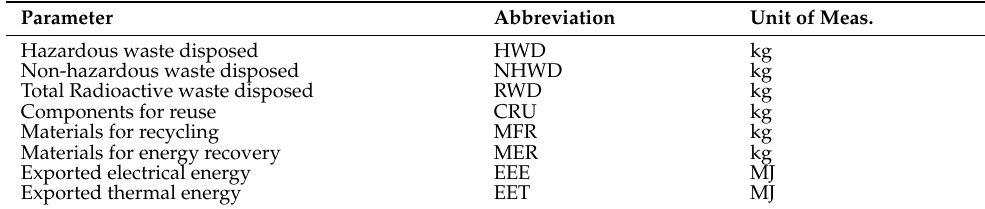
Table 3. Environmental impact parameters related to output flows and waste categories.